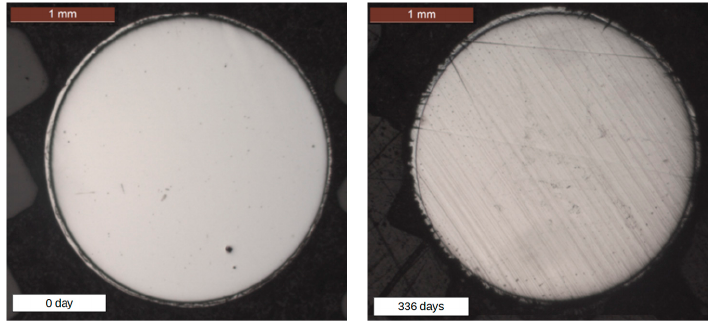
Figure 6. Transverse cross section of a corroded individual steel wire.